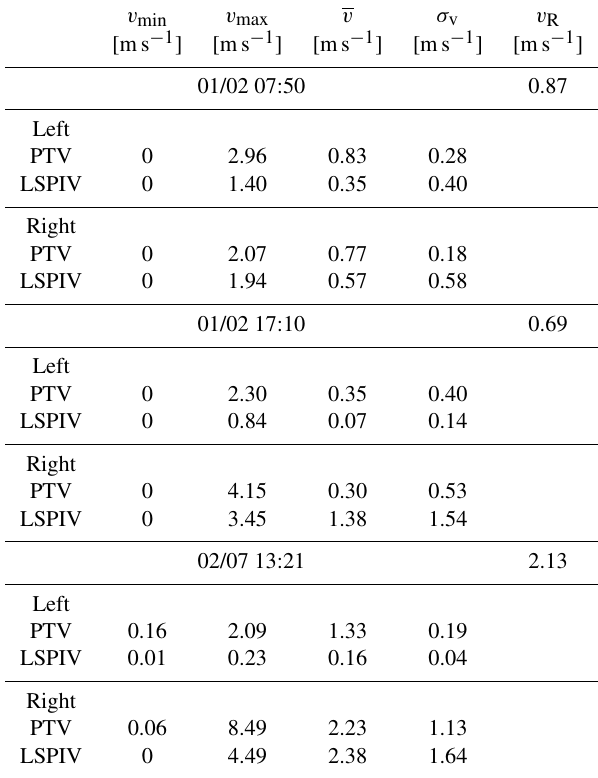
Table 3. Synoptic table of the statistics for time-averaged veloc- ity maps. Values indicate minimum ( v min ), maximum ( v max ), mean ( v ) velocities, and standard deviations ( σ v ) computed over time- averaged maps, and radar velocity ( v R